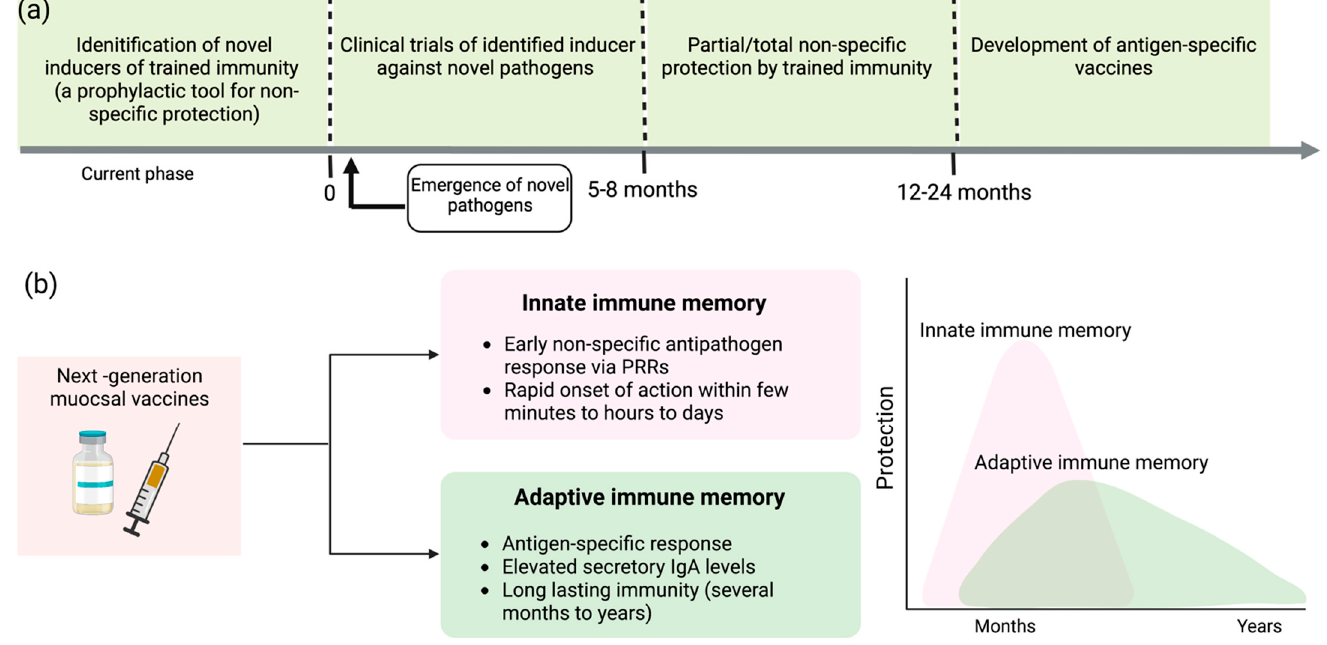
Figure 3. Bolstering trained immunity to elicit rapid response against emerging respiratory infections and to augment the efficacy of conventional vaccines. ( a ) Identification of safe and efficient inducers of trained immunity facilitates an innovative approach to fight or prevent the progression of novel pathogens. This provides valuable time to develop antigen-specific vaccines against novel microbes. ( b ) Next-generation hybrid vaccines integrate the unique features of innate and adaptive immune memory that can lead to a rapid onset of action and enhance the longevity of the protection window.